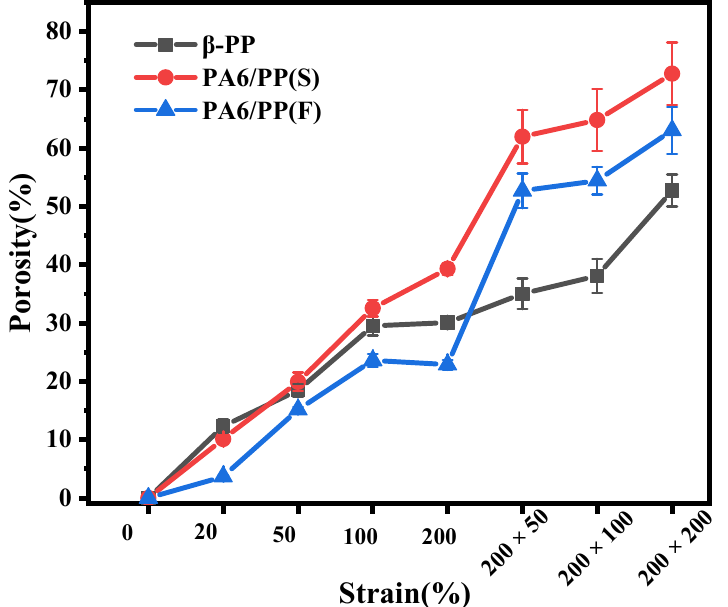
Figure 10. Variations in the porosity of β -PP, PA6/PP(S), and PA6/PP(F) membranes during the sequential biaxial stretching process.